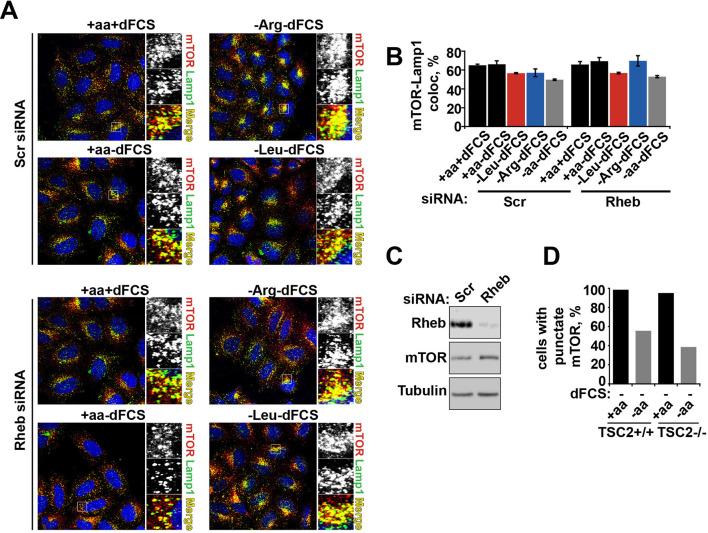
Rheb knock-down or hyperactivation does not affect mTOR localization.HeLa cells were treated with scramble control or Rheb siRNA (100 nM) for 96 hr. Cells were subjected to starvation protocols as indicated and fixed. Cells were immunostained with antibodies against mTOR and Lamp1 (A). Co-localization between mTOR and Lamp1 was quantified (B), and immunoblot was used to analyze mTOR protein levels in siRNA-treated cells (C). TSC2+/+ and TSC2-/- MEFs were incubated in the presence or absence of amino acids and the% cells with punctate mTOR was quantified (D).